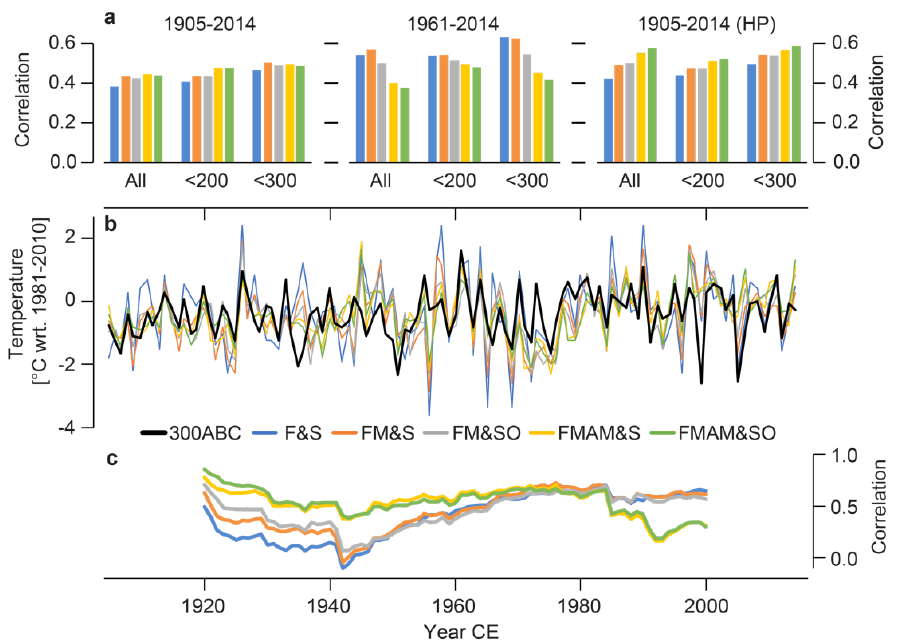
Figure 6. Temperature signal estimation. ( a ) Correlations of the ALL, ABC300 and ABC200 chronologies against seasonal temperatures (F&S, FM&S, FM&SO, FMAM&S, FMAM&SO) over the 1905–2014 period (left panel), 1961–2014 period (middle panel), and 1905–2014 period after high-pass filtering the data (right panel). ( b ) The ABC300 chronology in black shown together with five seasonal temperature records. The MXD chronology was scaled to the mean and variance of the FMAM&SO temperatures from 1905–2014. ( c ) Thirty-year running correlations between the seasonal temperatures and the ABC300 chronology from 1905–2014.